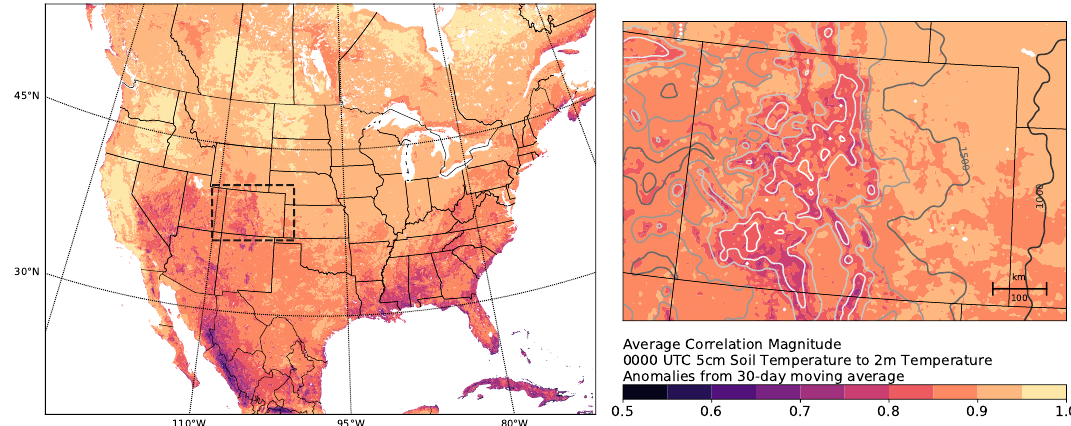
Figure 1. Average correlation magnitudes between simulated 2-m air temperature and 5-cm soil temperature anomalies from 30-day moving averages. Correlations taken at 0000 UTC-valid times from 16 July to 16 September, 2001–2010. Inset shows detail for the state of Colorado, an area with a wide variety of terrain. Elevations are contoured every 500 m. Source dataset: Rasmussen and Liu [50].